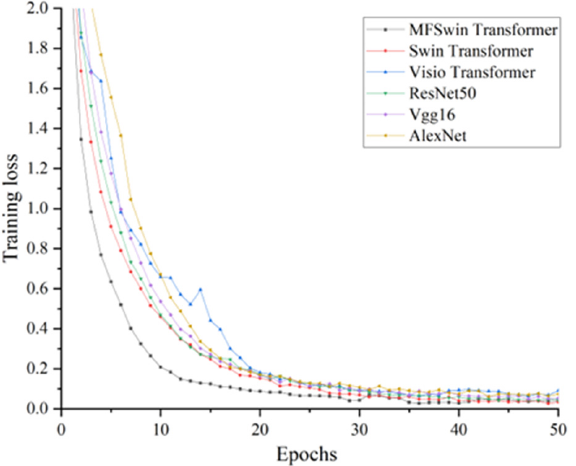
Figure 14. Relationship between model training loss and iteration rounds.